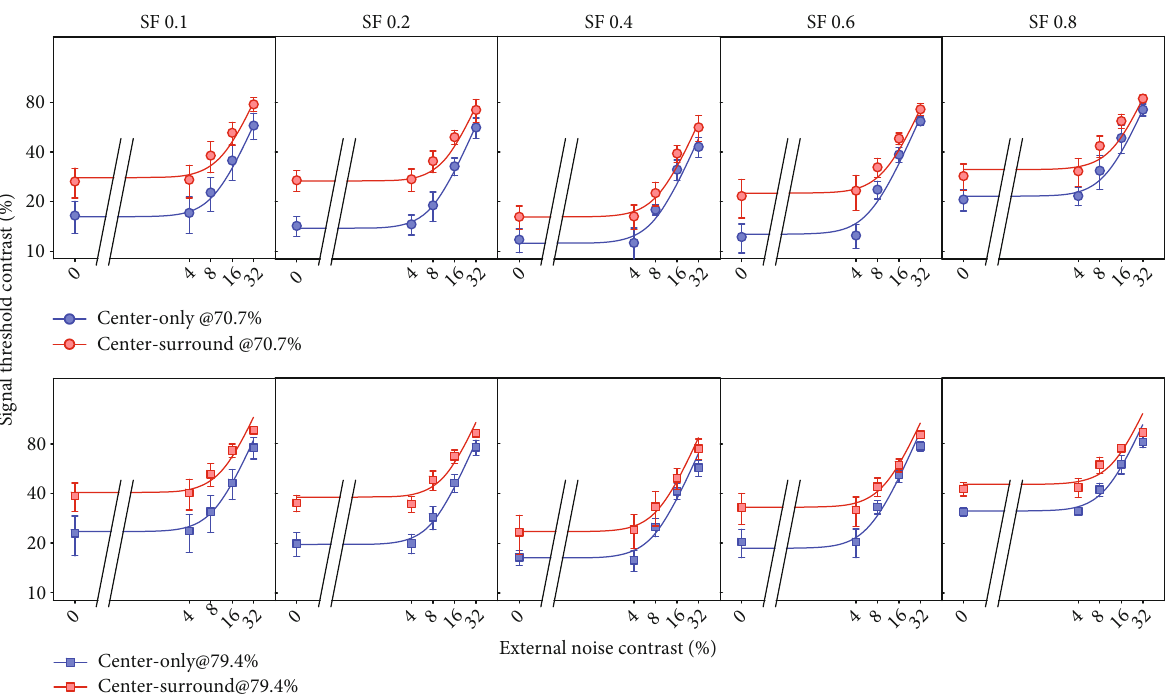
Figure 8: The log signal contrast threshold versus external noise contrast (TvC) functions at two performance criteria for NSS neurons ( n = 61 ) with di ff erent preferred SFs. The fi lled circles and squares with error bars represent, respectively, the mean signal contrast threshold at 70.7% and 79.4% performance accuracy with (red color) and without (blue color) the presence of surround stimuli. The blue and red solid curves are the best- fi tting TvC functions with PTM model under each